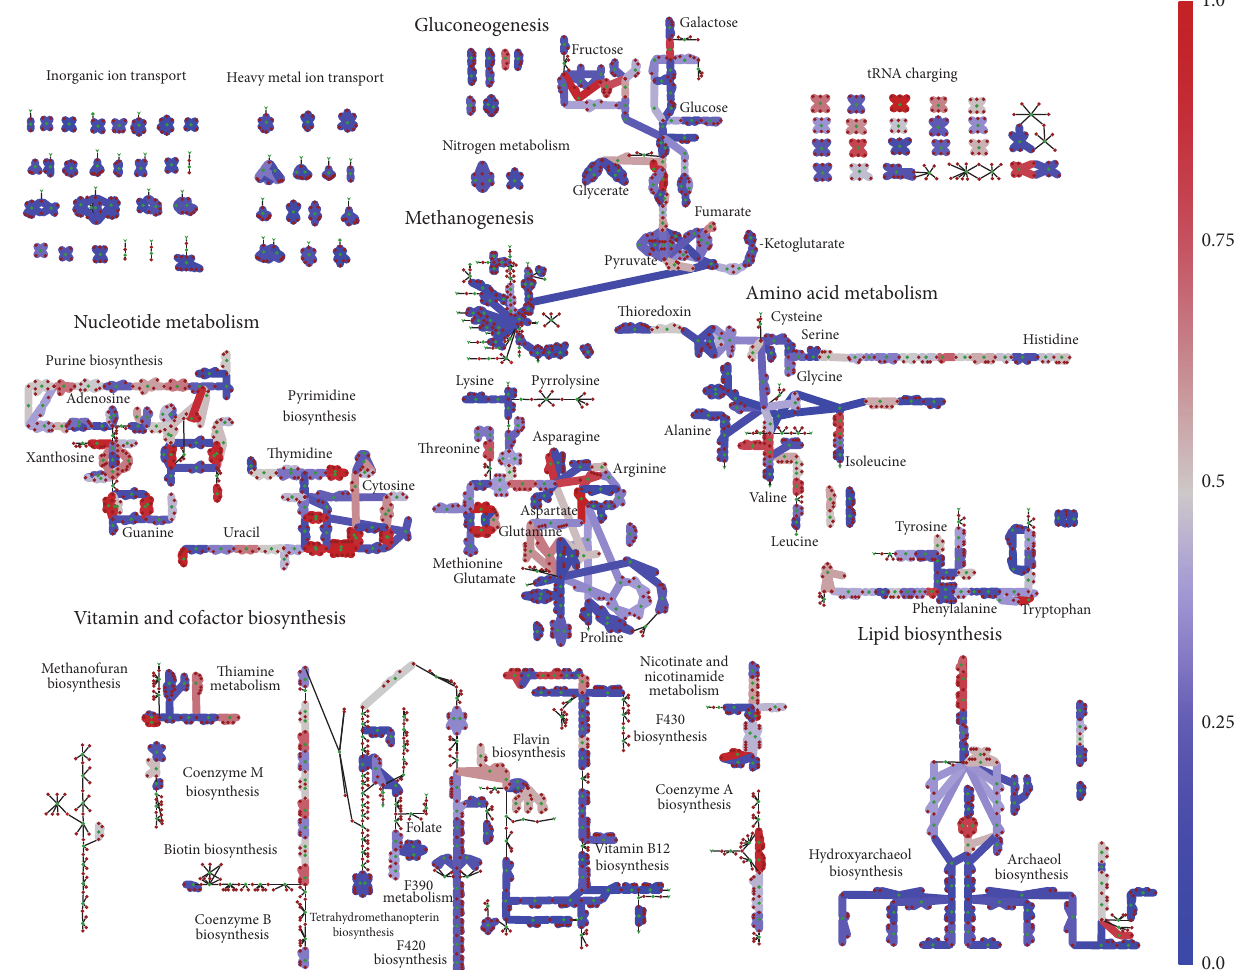
Figure 5: Conservation of metabolic reactions. A map showing the extent of conservation for the reactions of the M. acetivorans model i ST807 (as encoded in the gene-protein-reaction associations (GPRs) of the model). Nodes represent either a metabolite or reaction and edges indicate the dependencies between reactions and metabolites. Reactions on the blue end of the spectrum are facilitated by enzymes that are conserved in relatively few of the 221 archaea in the database while reactions in red are facilitated by highly conserved enzymes. Reactions with thin grey lines are not associated with genes. To assess conservation, the db evaluateReactionsFromGpr.py functionality of the ITEP software [45] was used. It computes homologous genes to those in the GPRs of each reaction in i ST807. The ITEP function was executed with the “or” option enabled to identify whether any of the enzymes (or enzymatic subunits) annotated as facilitating the reactions were encoded in the